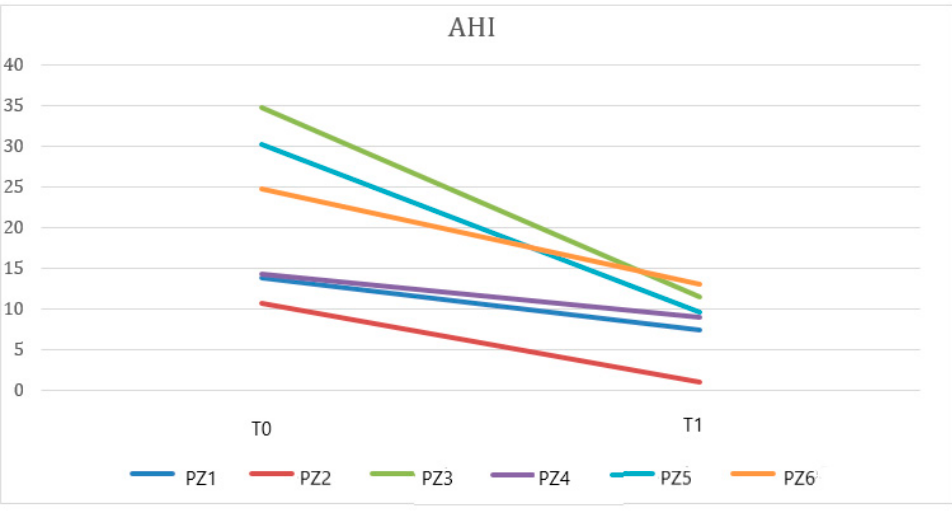
Figure 2. A paired data t-test showed a significant difference between AHI at T0 and T1 ( p < 0.05) when evaluating data from patients (PZ) treated with the OrthoApnea NOA ®